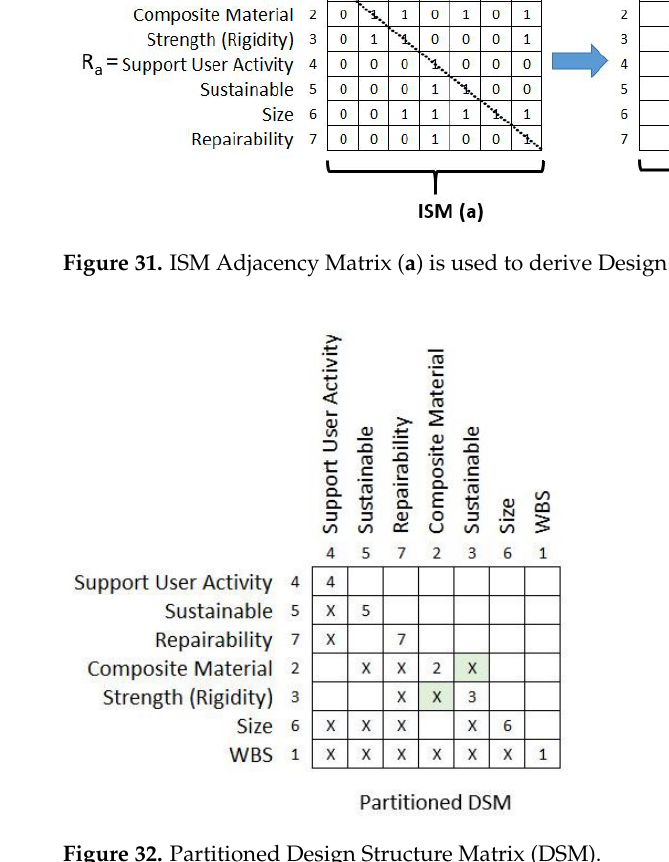
Figure 32. Partitioned Design Structure Matrix